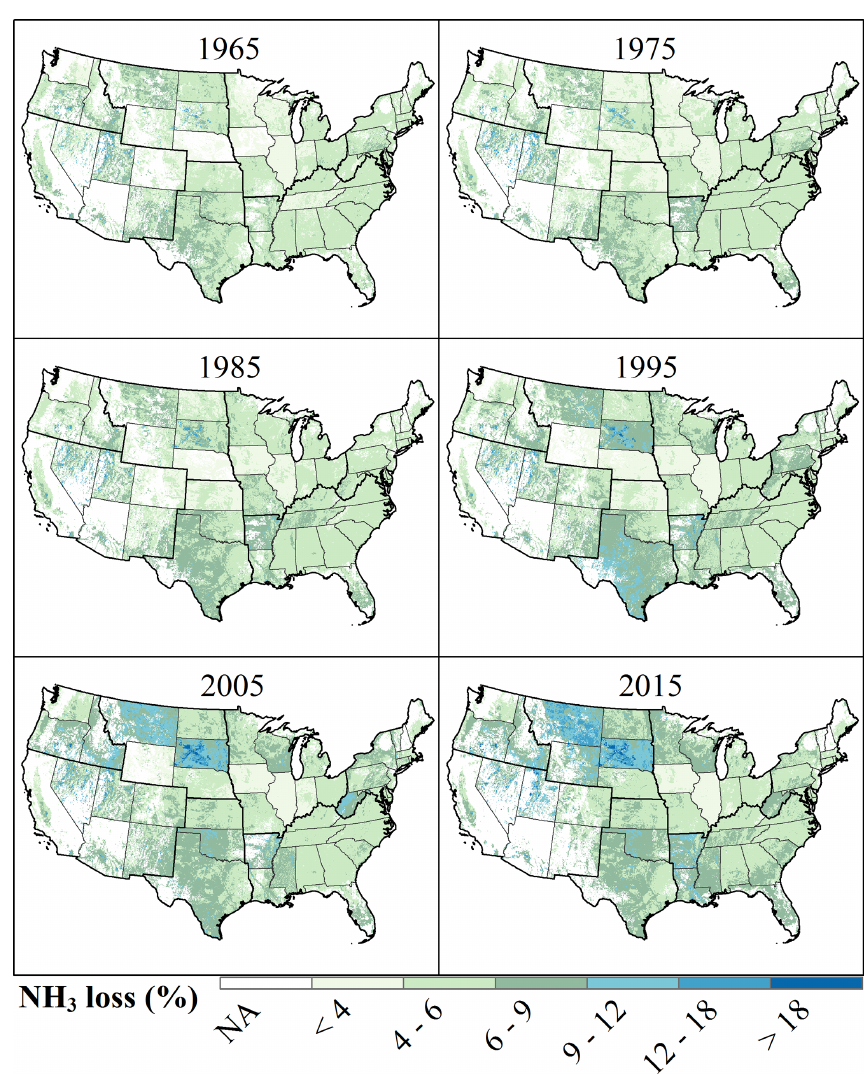
Figure 4. Spatial and temporal patterns in NH 3 loss proportion relative to total N fertilizer input in the US (the middle year of each decade is selected as an